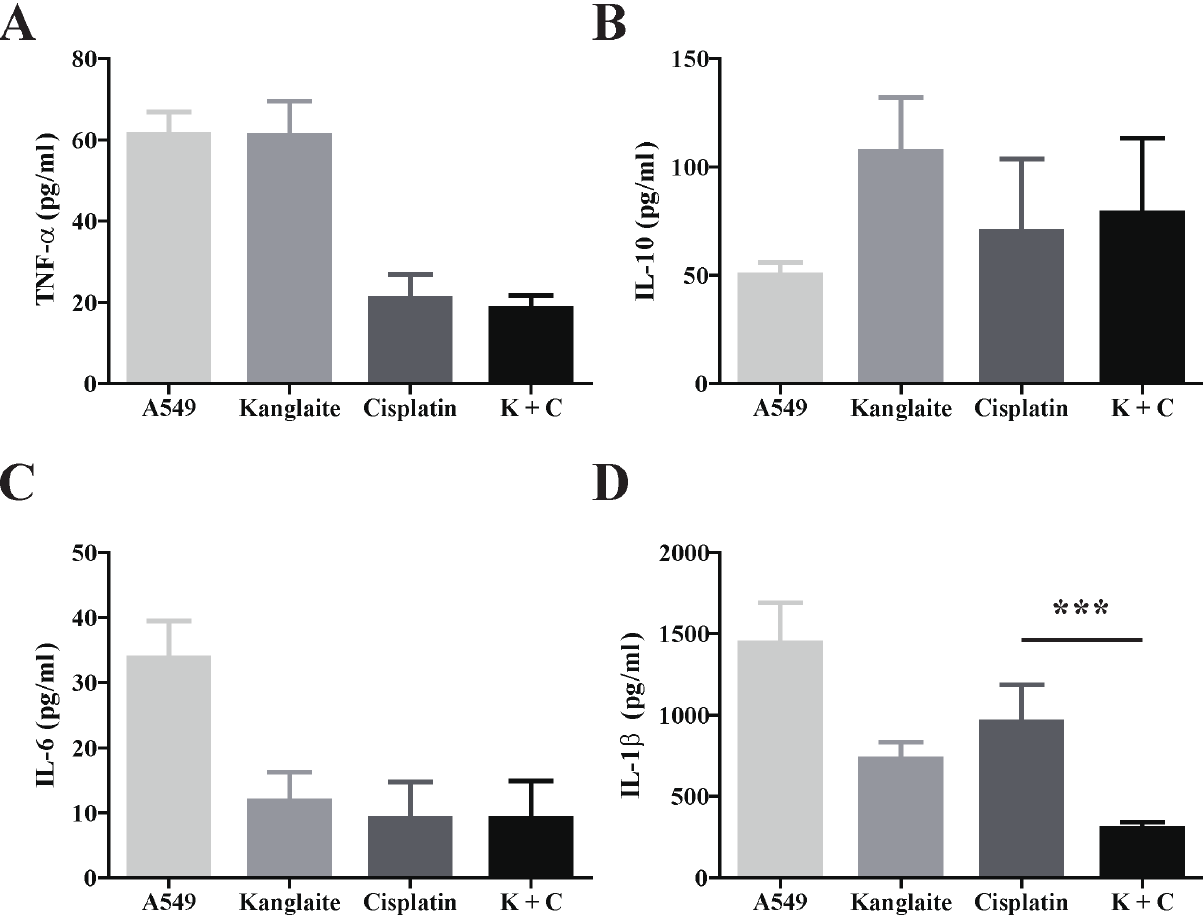
Fig. 3. Effects of Kanglaite on the serum concentration of the cytokine in the mice model. Serum level of TNF- α (A), IL-10 (B), IL-6 (C), and IL-1 β (D) was determined by ELISA. Data shown as mean with SEM ( n = 5) and *** P < 0.001.